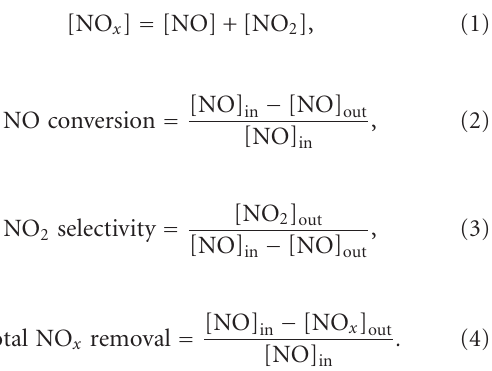
by an on-line chemiluminescent NO x analyzer (Eco Physics, CLD 700AL). In addition, blank test was performed under the same condition except photocatalyst existence. The result certainly guaranteed all the materials of the system inactive on photocatalytic De-NO x